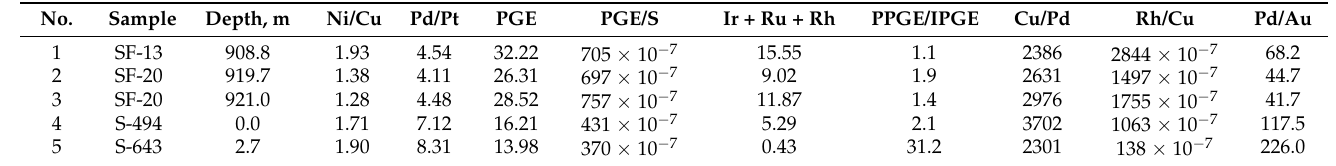
Table 6. Geochemical features of the massive exocontact ores (in 100% sulfide) from the Skalisty mine. Northeastern part of the Talnakh